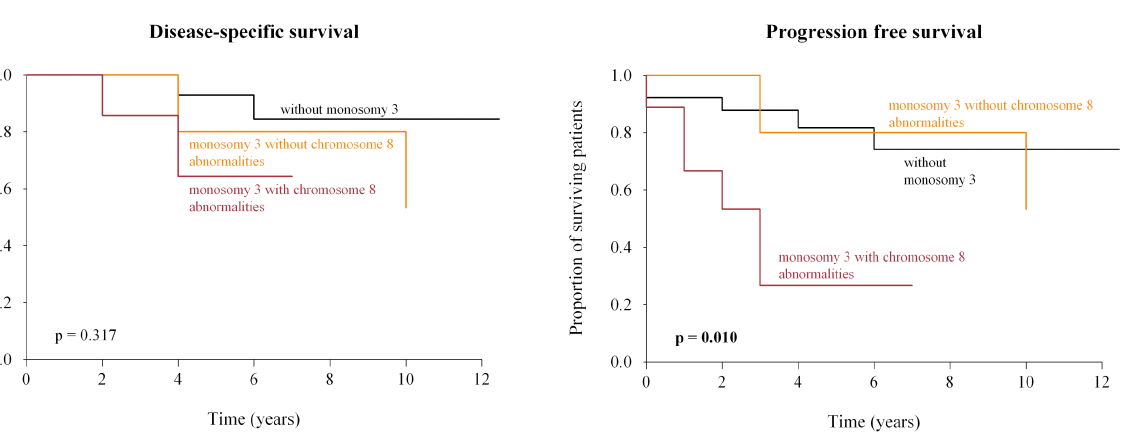
Fig. 3. Disease-specific survival (until death due to observed diagnosis of melanoma) by abnormalities of chromosome 3 and 8 (P value of log-rank test is presented).